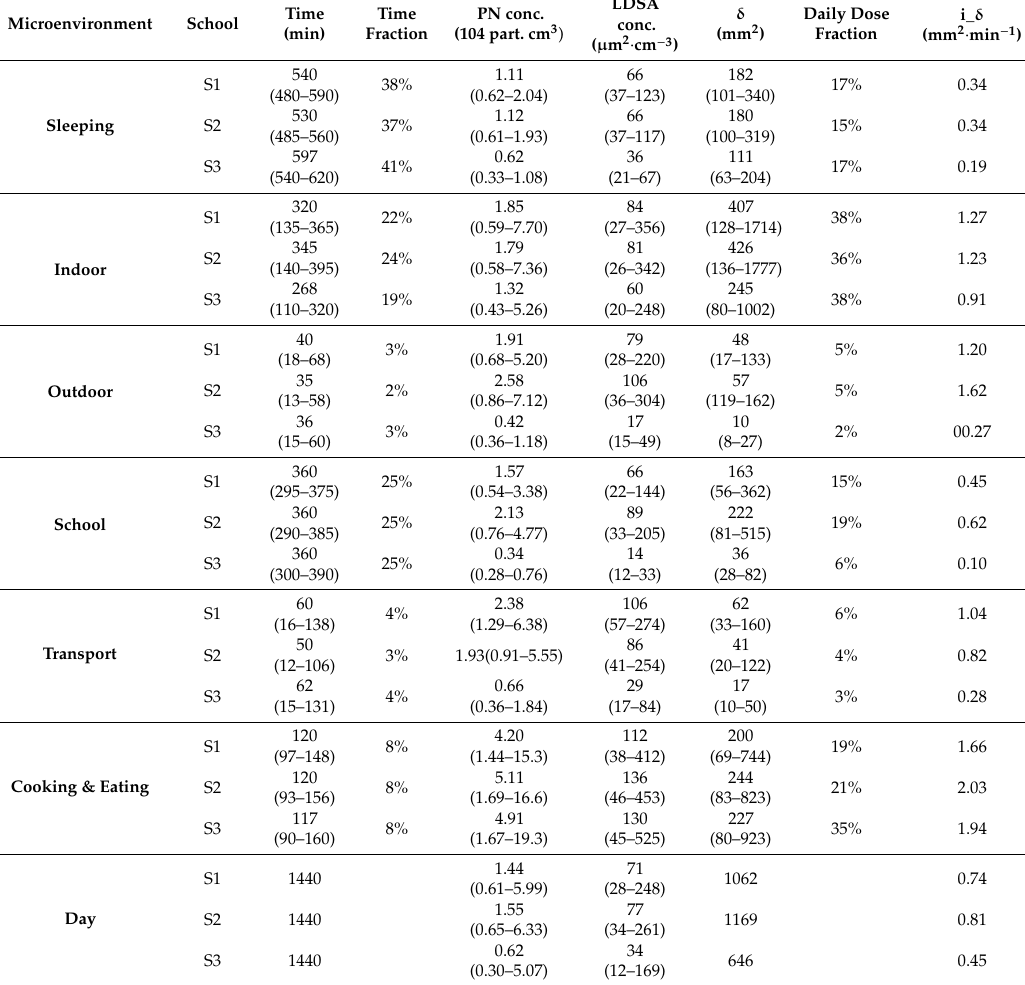
Table 3. Time activity pattern, particle concentrations (PN and LDSA) and dose received by children of the three schools in the di ff erent microenvironments expressed as median values and range (5th and 95th percentile). Total daily doses as sum of the median doses received in the di ff erent microenvironments are also reported as well as daily dose fractions and intensity–dose